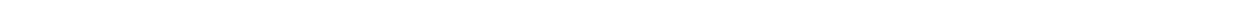
Fig. 4 Chro prevents low-level nuclear Pros to promote and maintain NSC reactivation. a A schematic diagram represents pros regulatory region upstream of translation start site and pros coding sequence region. Primers designed in pros regulatory region (pro1-pro6) and pros CDS region were indicated in blue bars . b Quanti fi cation of fold enrichment in ChIP-qPCR assay using anti-Chro-C and control for different pros gene regions. The CDS region of pros is used as control. c Third-instar larval NSCs from control, chro RNAi knockdown and chro − were labelled with Mira, Pros and ToPro-3. Nuclear Pros in NSCs: control, 0%, n = 786; chro RNAi, 74%, n = 385; chro − , 75%, n = 491. d Pros, Mira and Dpn were labelled in the NSCs of various genotypes. Nuclear Pros in NSCs: control, 0%, n = 627; chro 612 /Df(3L)ED231, 71%, n = 984; chro 17a/71 , 80%, n = 829; chro 8c/71 , 73%, n = 405; grh 370 , 50%, n = 522; grh 370/Df , 58%, n = 861. e NSC clones from control and Mtor k03905 were labelled with Pros, Dpn and CD8. f Larval brains in chro − and chro − pros 17/ + were labelled by EdU and Dpn. g Quanti fi cation of percentages of Dpn + EdU + cells in chro − (24 ± 2%) and chro − pros 17/ + (44 ± 2%) larval brains. h Pros, Mira and Dpn were labelled in the NSCs in chro − and chro − pros 17/ + . Nuclear Pros in NSCs: chro − , 75%, n = 858; chro − pros 17/ + , 57%, n = 1240. i Quanti fi cation of percentages of NSCs with cellular extensions in chro − (27 ± 2%) and chro − pros 17/ + (10 ± 1%) larval brains. j , k NSC clones from Mtor k03905 or Mtor k03905 ; pros 17/ + were labelled with Dpn, Mira and CD8 or EdU, Mira and CD8. NSCs with cellular extensions: Mtor k03905 , 46%, n = 106; Mtor k03905 ; pros 17/ + , 26%, n = 95. EdU − Mira + NSC clones: Mtor k03905 93%, n = 102; Mtor k03905 ; pros 17/ + , 60%, n = 65. All error bars indicate ± SD in b , g and i . *** indicates P < 0.001 in g , i by Student ’ s t -test. NSC clones were outlined by white dotted lines in e , j and k . White arrows indicated NSCs and arrowheads indicated the cellular extension of NSCs. Scale bars, 10 µ